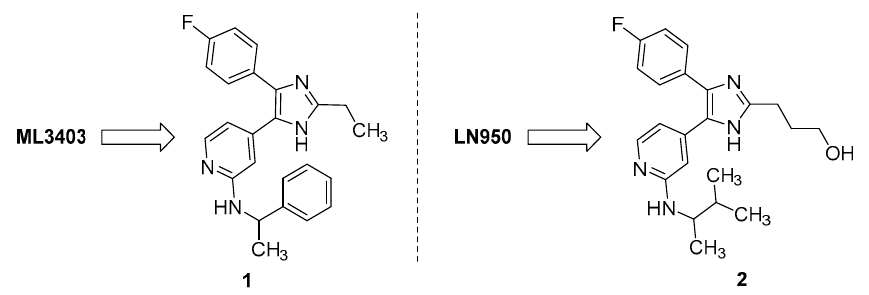
Figure 2. Modifications of ML3403 and LN950 .